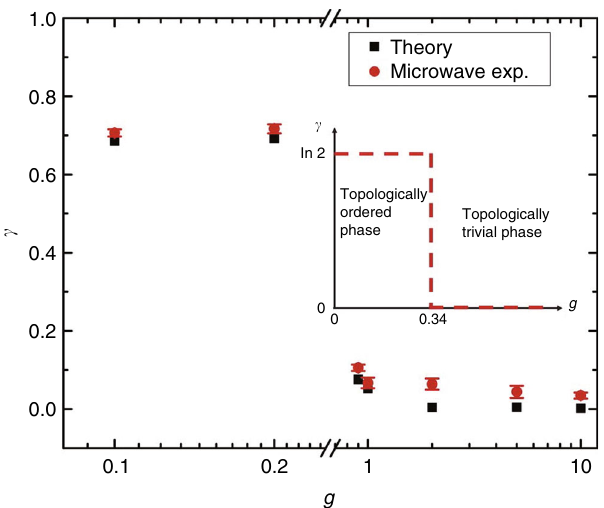
Fig. 5 The TEE for the square lattice with strength of external fi elds g . Red circles represent results from the microwave experiments. Black squares are theoretic results of TEE obtained from the corresponding MESs. Inset: when the model belongs to Z 2 topological order, the long-range entanglement in the MES indicated as the TEE is γ = ln2; the model belongs to the trivial phase when the external fi eld becomes strong and the TEE is γ = 0. Error bars are de fi ned as s.d. Source data are provided as a Source Data fi